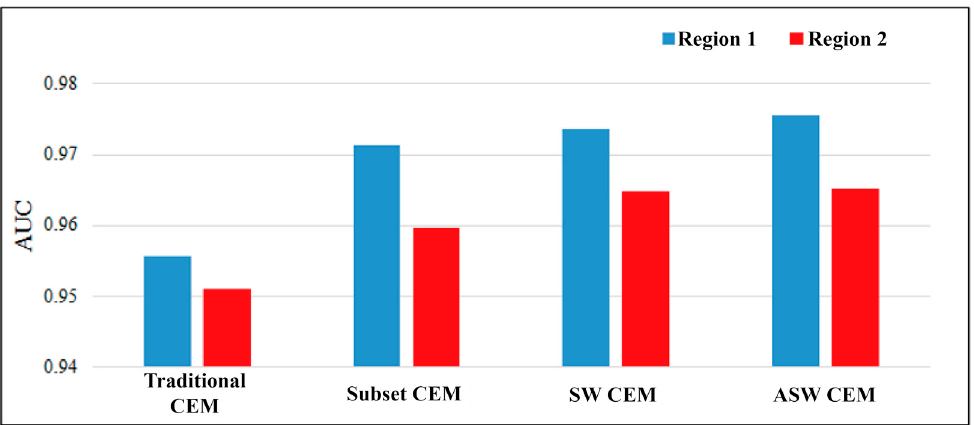
Figure 20. Area under curve (AUC) detection results of Region 1 and Region 2.